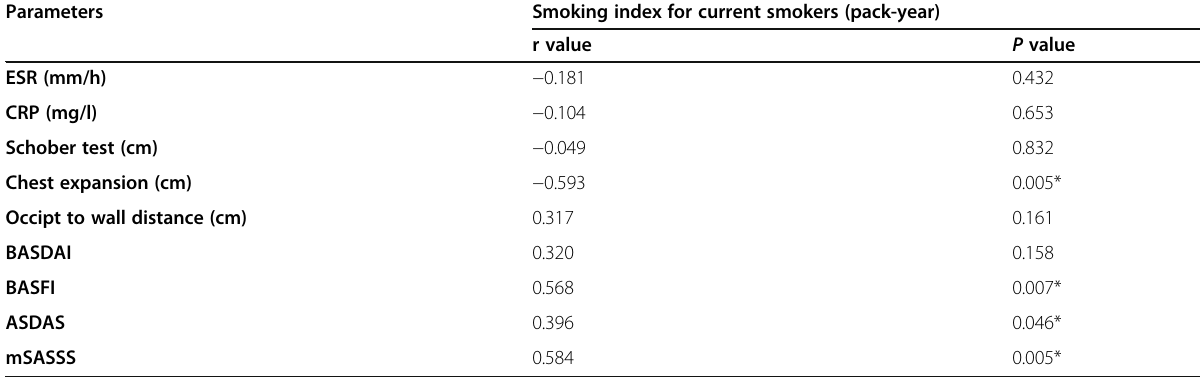
Table 3 Correlation between smoking index for current smokers (pack-year) with other parameters in the AS study groups Parameters